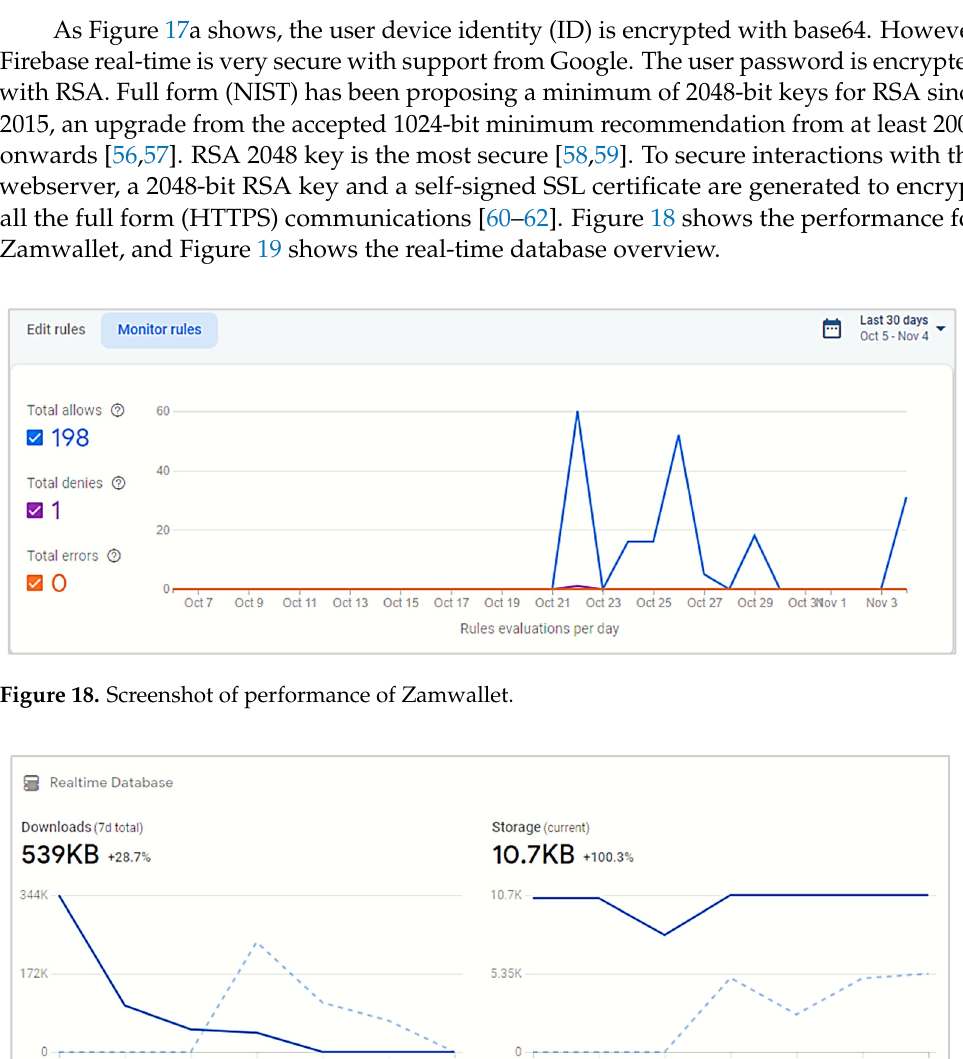
Figure 17. Overview of real-time database activities. ( a ): User information on Firebase database and ( b ): user transaction details on Firebase database.